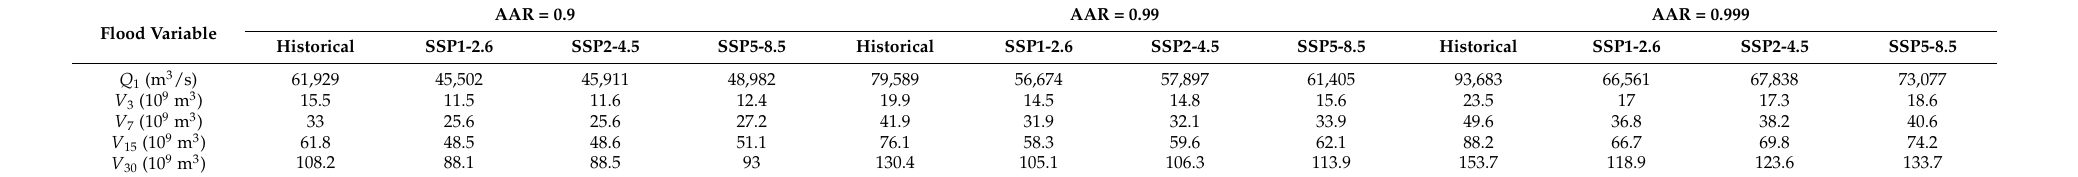
Table 6. Multivariate dam-site design floods associated with Kendall exceedance probability for the TGR.